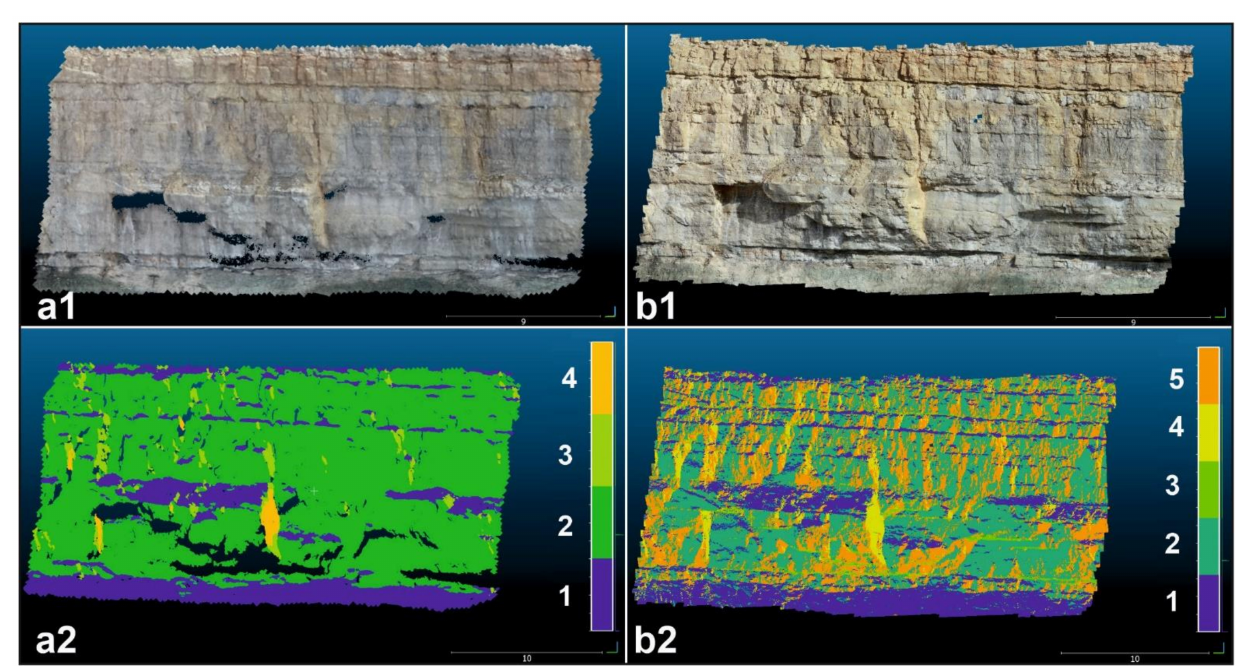
Figure 8. Point clouds ( 1 ) and discontinuity orientations ( 2 ) in two drone settings: AMSL-40 ◦ -off-nadir ( a ) and facade-nadir ( b ). The number of the legends correspond to the discontinuity orientations of Table